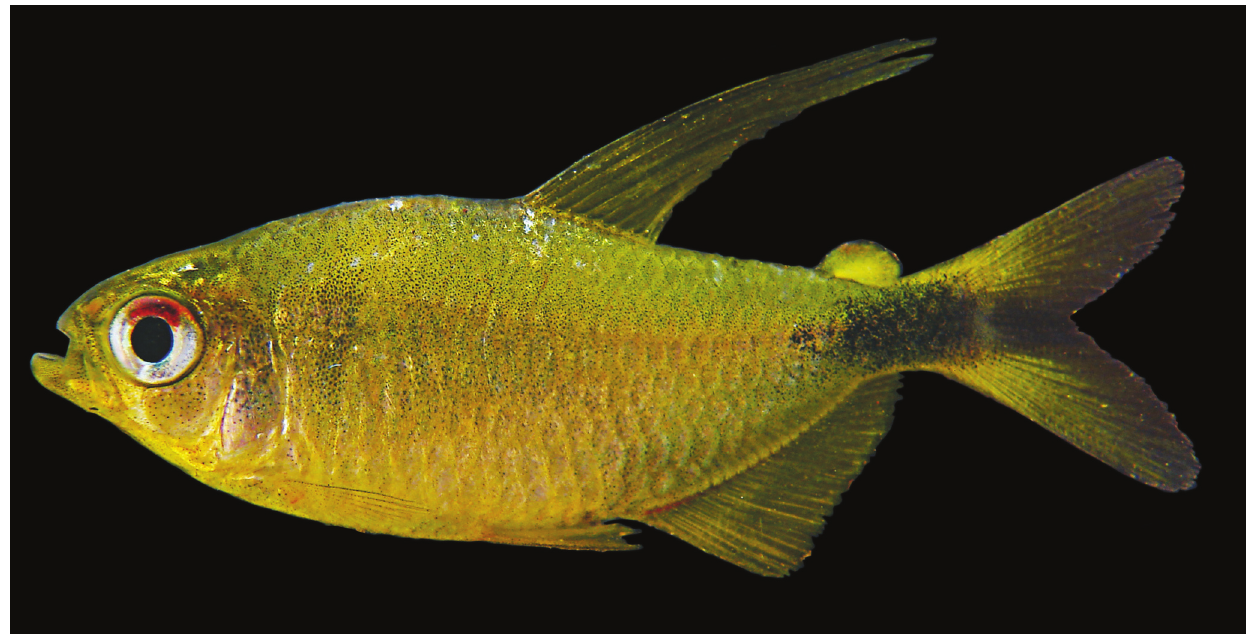
Fig. 9. Live specimen of Hyphessobrycon loweae , MZUSP 97435, 27.6 mm SL, male, Brazil, Mato Grosso State, rio Culuene